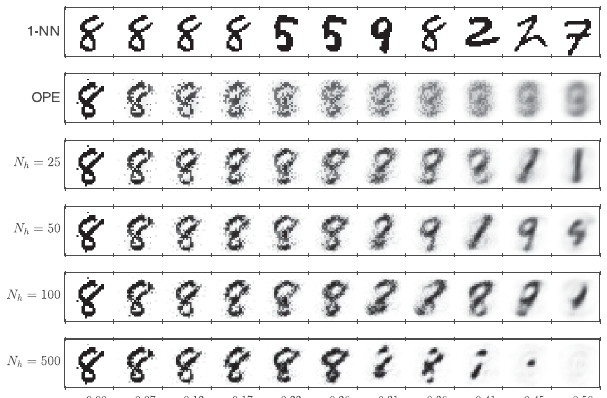
FIG. 9. Subjective comparison of denoising estimates for a single-digit image for p ¼ ½ 0 ; 0 . 5 (cid:2) . For the OPE and RBM approaches, the inferred posterior averages h x i i are shown, rather than the final configurations, where white and black represent the values 0 and 1, respectively. At each tested value of p , the same noise realization is used for each method. As p increases, for N 25 ; 50 ; 100 g , the TAP inference for the RBM provides h ¼ f estimates which still possess digit structure. In the case N 500 , the TAP inference gets caught in spurious and h ¼ undesirable minima as p